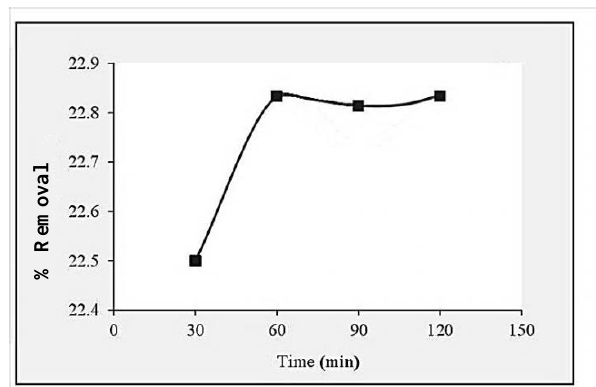
Figure7. Effect of contact time on ferrous ion